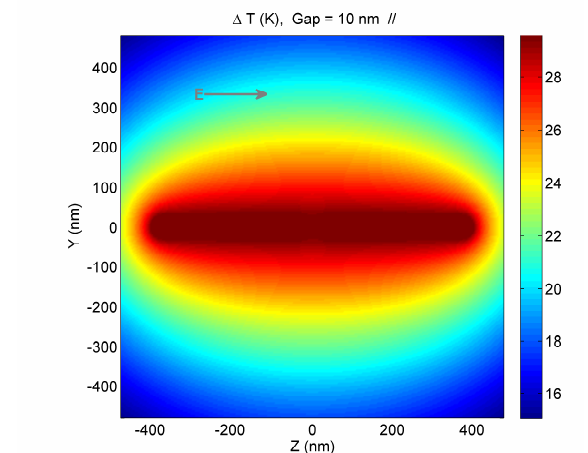
Figure 3: Temperature elevation, solution of the stationary heat equation. L = 400 nm, R 1 = 30 nm and a 10 nm